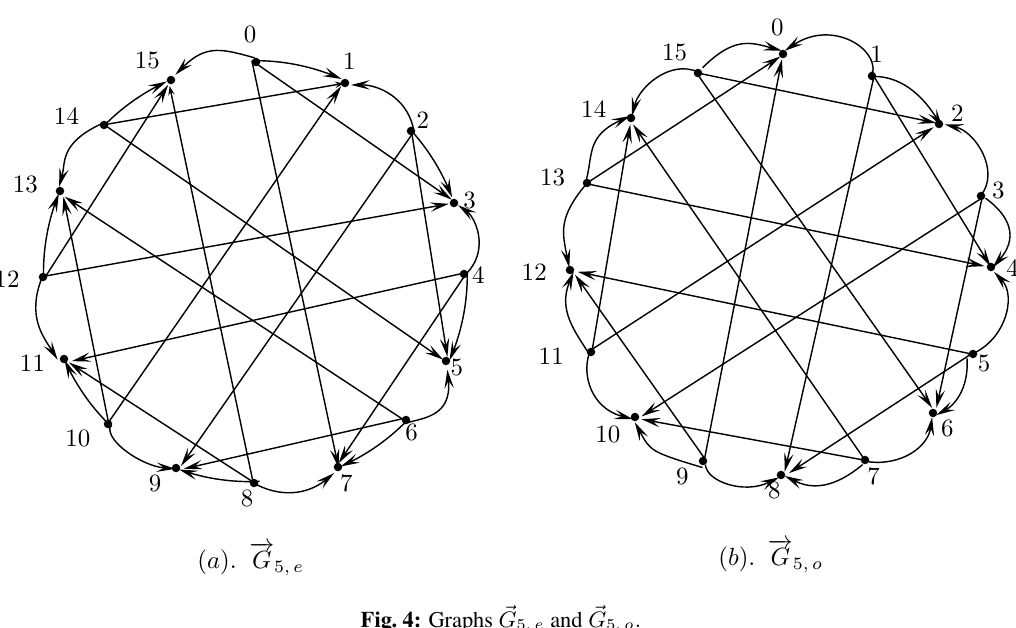
Fig. 4: Graphs ~G 5 ,e and ~G 5 ,o